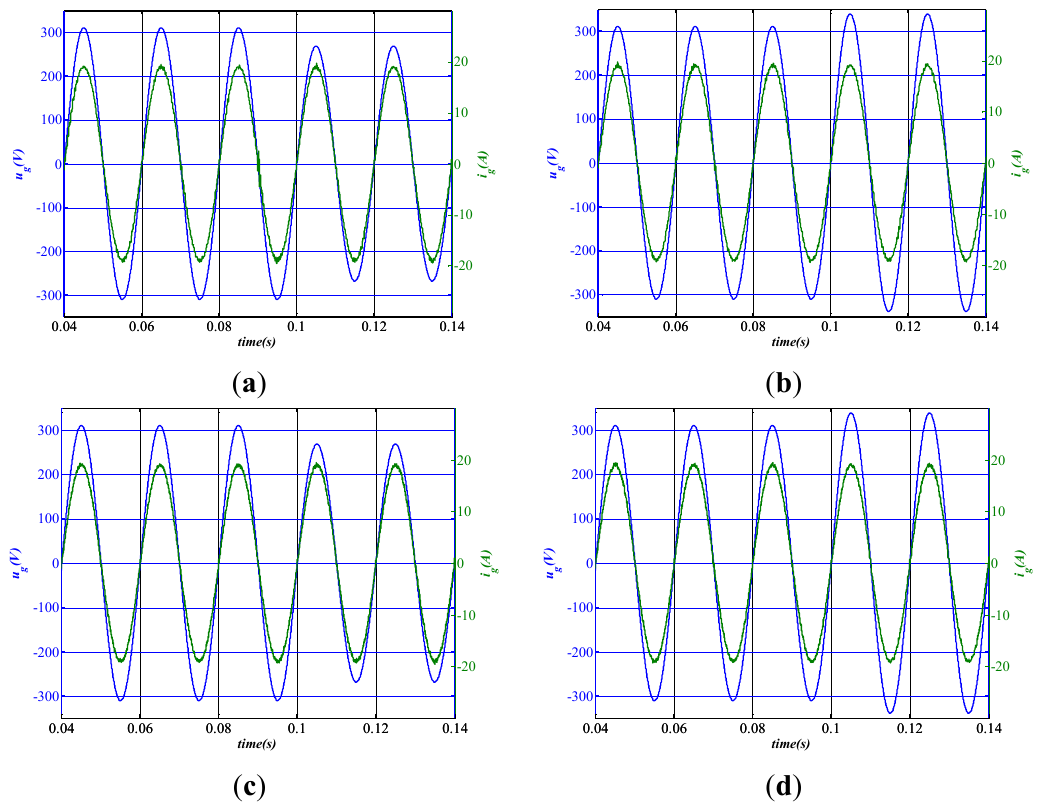
Figure 17. Grid voltage and injected current at full load with inductor L variation: 2 simulation results. ( a ) Inductor L increased by 150%: grid voltage sag; ( b ) inductor L 2 2 increased by 150%: grid voltage swell; ( c ) inductor L decreased by 20%: grid voltage sag; 2 ( b ) inductor L decreased by 20%: grid voltage swell. 2